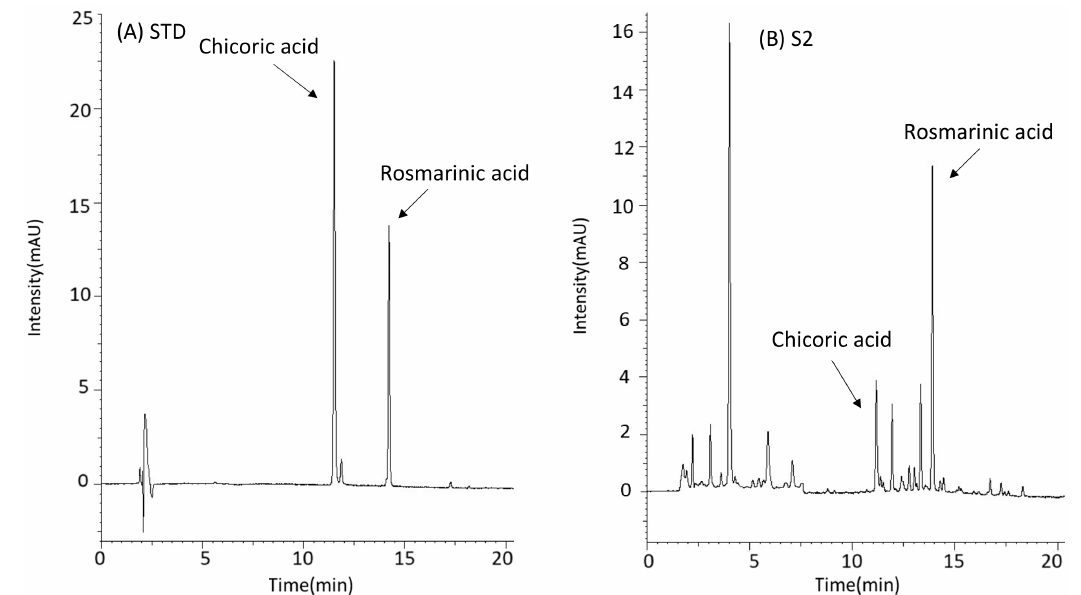
Figure 5. HPLC chromatograms of ( A ) rosmarinic and chicoric acids reagent and ( B ) S2. S2: Steaming for 2 min.